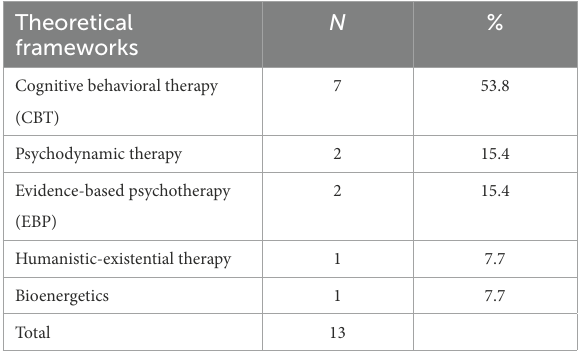
TABLE 2 Self-identified theoretical orientation of the psychotherapists ( N =